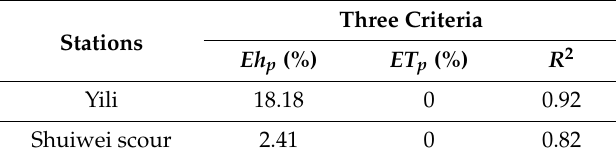
Figure 9. Comparisons of the measured and simulated water levels at ( a ) Shuiwei scour and ( b ) Yili gauging stations for Typhoon Nesat (July 2017). Table 3. Simulated results for three criteria of Typhoon Nesat obtained using the SFM2D model.